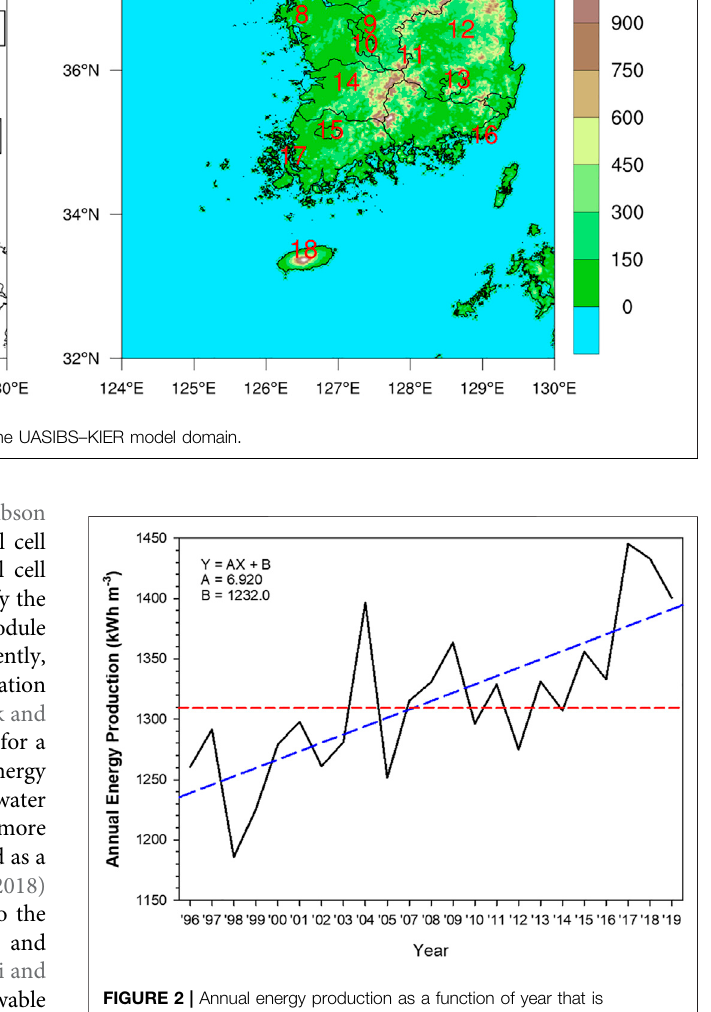
FIGURE 2 | Annual energy production as a function of year that is derivedfromthesolarirradiance.Bluedashedlineindicatestheregressionline from 1996 to 2019. Red dashed line is the climatological mean from 1996 to